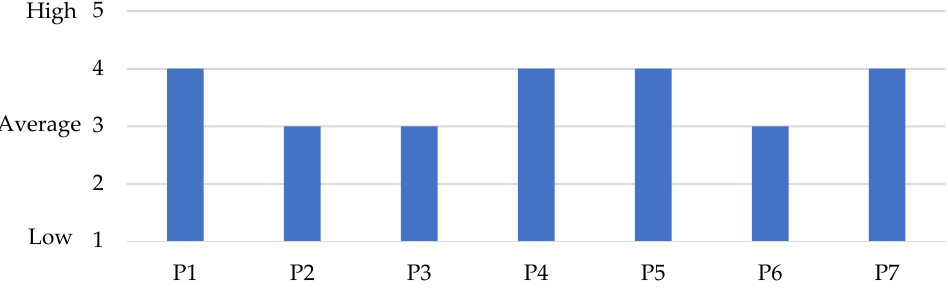
Figure 4. Participant freeform modelling knowledge: self-evaluation. Three out of seven students have tried using VR equipment before, but only once and it was for videogames. None of the participants owns a VR headset, nor did any of them tried using VR for 3D modelling before this study. Figure 5 shows participants’ interest in VR technology and their opinion on the perspective of using this technology in engineering.